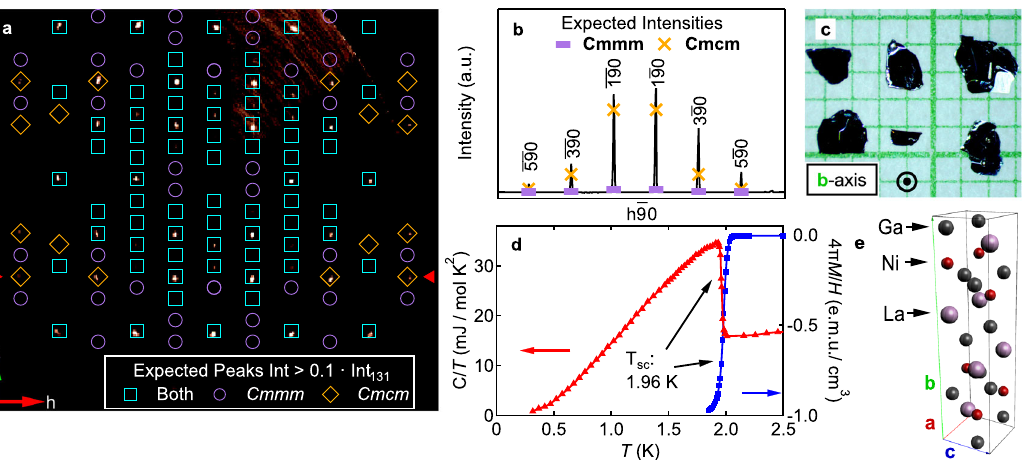
Fig. 1 Structural and superconducting properties of LaNiGa 2 single crystals. a Compiled precession image of the hk 0 plane from a single-crystal X-ray diffraction data set of LaNiGa 2 . Overlaid are the predicted diffraction spots with a normalized intensity above 0.1. The diffraction spots are normalized to the 131 diffraction peak. The diffraction spots which are expected for both the original Cmmm 24 and our newly proposed Cmcm structures are denoted by the teal squares. The spots which are only expected for the Cmmm and Cmcm structures are shown by the purple circles and orange diamonds, respectively. b A normalized linear cut of the hk 0 precession image along the h 90, shown by the red triangles in a . The expected intensities for the Cmmm and the Cmcm structures are shown as the purple dashes and the orange crosses, respectively. All intensity data, raw and theoretical, from a and b are normalized to the 131 peak. c Picture of representative single-crystal samples of LaNiGa 2 . The plate-like samples have the b -axis normal to the surface of the crystals. d A complete superconducting transition is observed with zero- fi eld speci fi c heat capacity ( C / T ) and zero- fi eld cooled magnetic susceptibility ( M / H ) data, shown by the red and blue curves, respectively. The susceptibility was collected with an external magnetic fi eld of 1 mT. e The Cmcm unit cell for LaNiGa 2